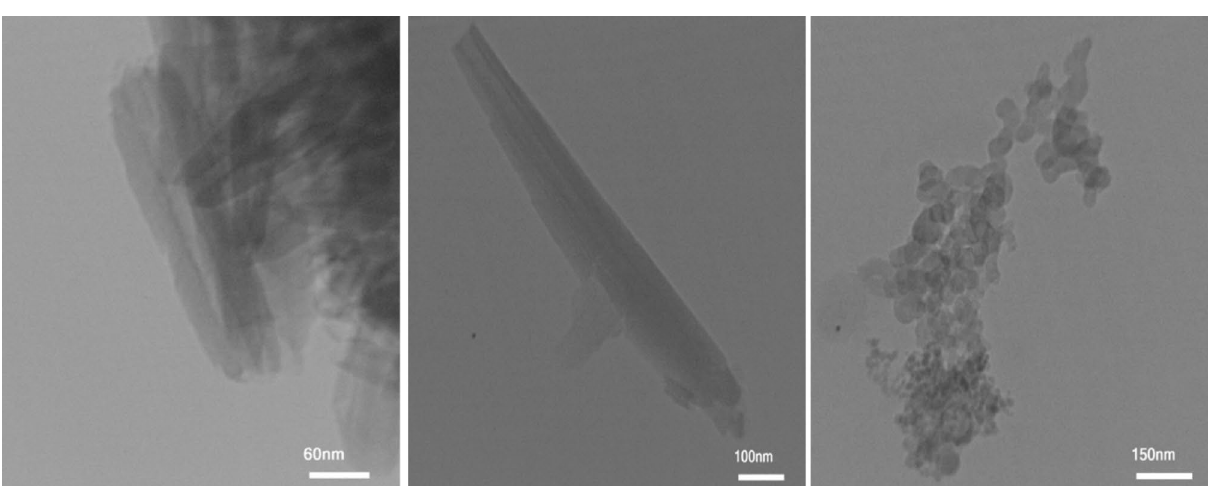
Figure 4. TEM images of